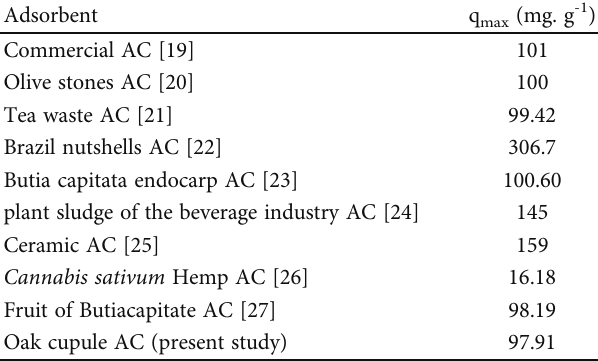
Table 5: Comparison of PA adsorption onto ACO with other reported